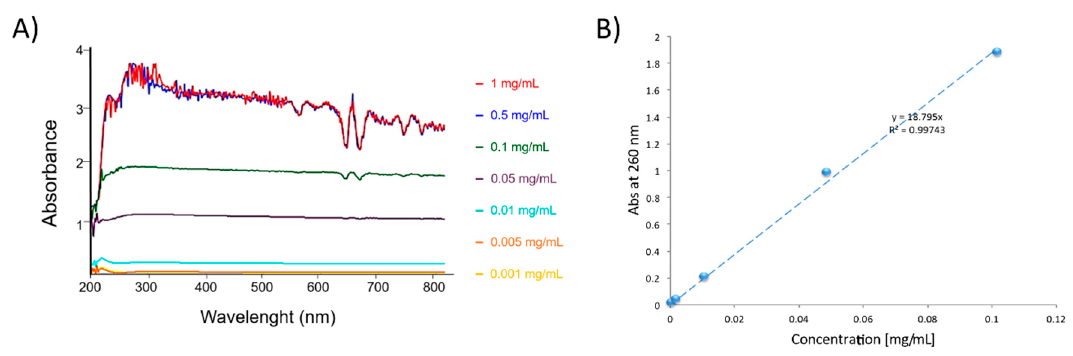
Figure 7. ( A ) Dependence of UV-Vis absorbance on the concentration of MWCNT / PPGP c adduct in water after sonication; ( B ) Linear relationship between absorbance at 260 nm and concentration for MWCNT / PPGP c adduct.